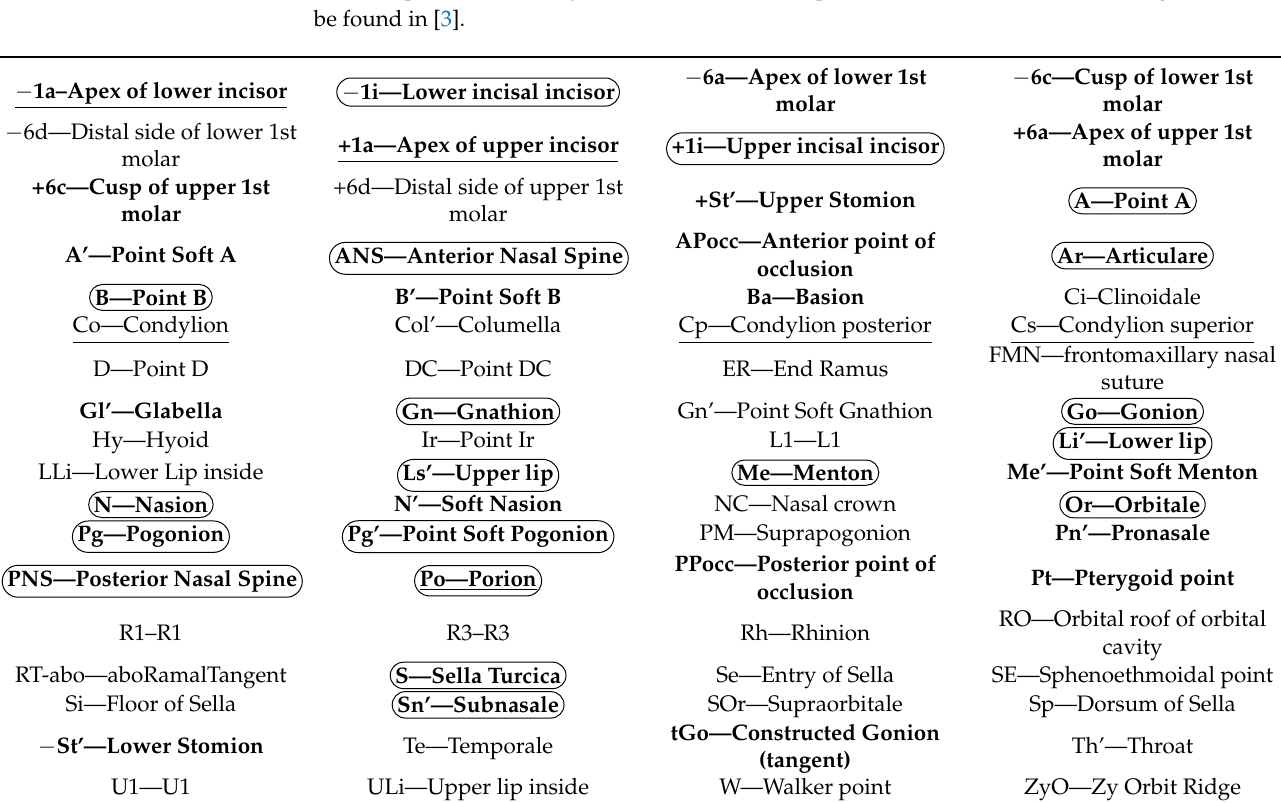
Table 2. A list of 72 cephalometric landmarks annotated in the AUDAX private database.